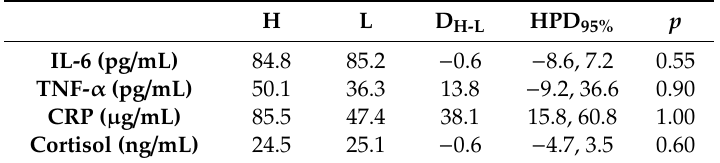
Table 3. Cytokines, C-reactive protein (CRP), and cortisol concentrations in female rabbits from the high and the low